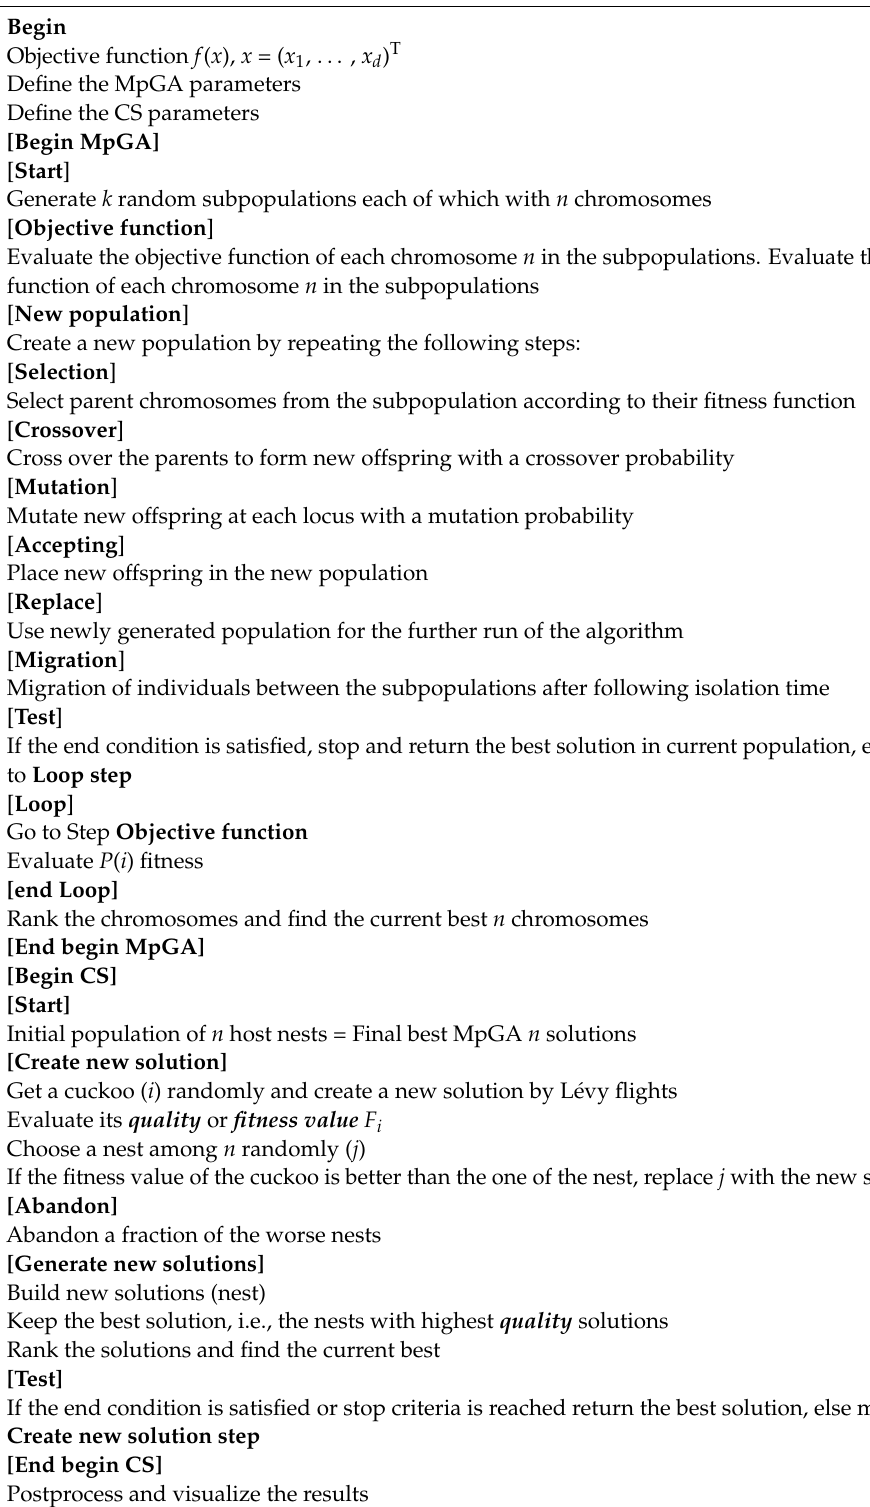
Algorithm A1 Pseudo Code of MpGS-CS Hybrid